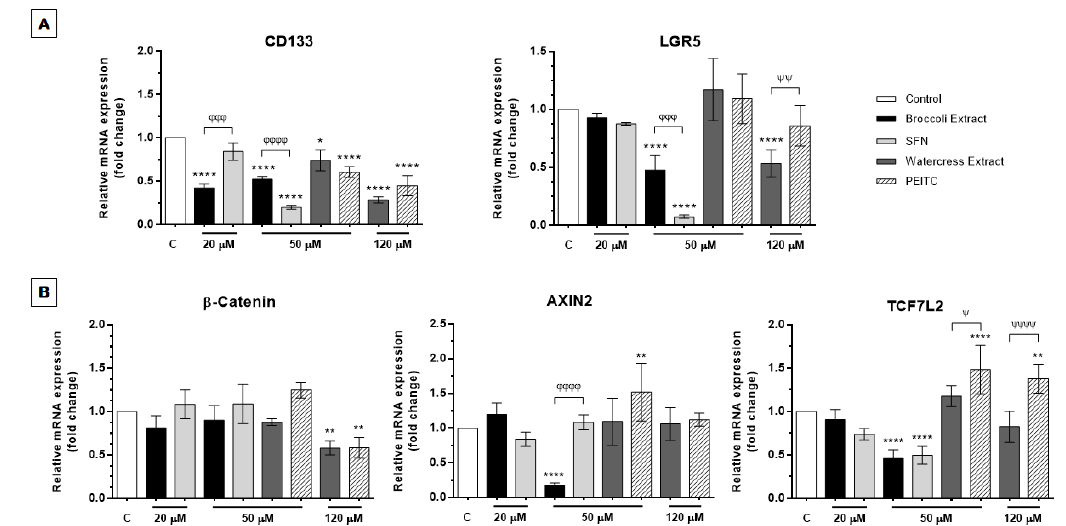
Figure 7. Effects of natural extracts and ITCs in expression of stemness markers ( LGR5 and PROM1 ) and players of the Wnt/ β‐ catenin/TCF7L2 signaling axis ( CTNNB1 , AXIN2 , TCF7L2 ) related with tumor onset and progression in HT29 spheroids after a 24 h’s treatment; data normalized relatively to treatment with the same % ( v / v ) of solvent used for each extract/compound. GAPDH was used as endogenous control. ( A ) Analysis of LGR5 and PROM1 (coding for CD133) markers expression by qPCR; ( B ) Analysis of CTNNB1 (coding for β‐ catenin), AXIN2 and TCF7L2 expression by qPCR. For extracts’ EC 50 values (50 and 120 μ M for broccoli and watercress extracts, respectively) results are expressed as mean of two independent experiments performed in triplicate ± SD. For the tested dose bellow the EC 50 value, results are expressed as mean of one experiment performed at least in triplicate ± SD. * p < 0.05, ** p < 0.01 and **** p < 0.0001 are relative to control; ϕϕϕ p < 0.001 and ϕϕϕϕ p < 0.0001 are relative to broccoli extract; Ψ p < 0.05, ΨΨ p < 0.01 and ΨΨΨΨ p < 0.0001 are relative to watercress